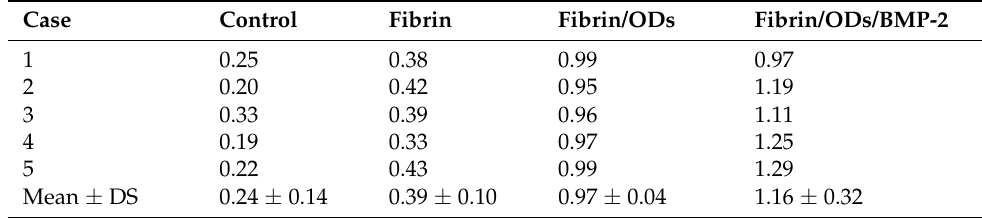
Table 2. Dentin bridge thickness ( µ m).